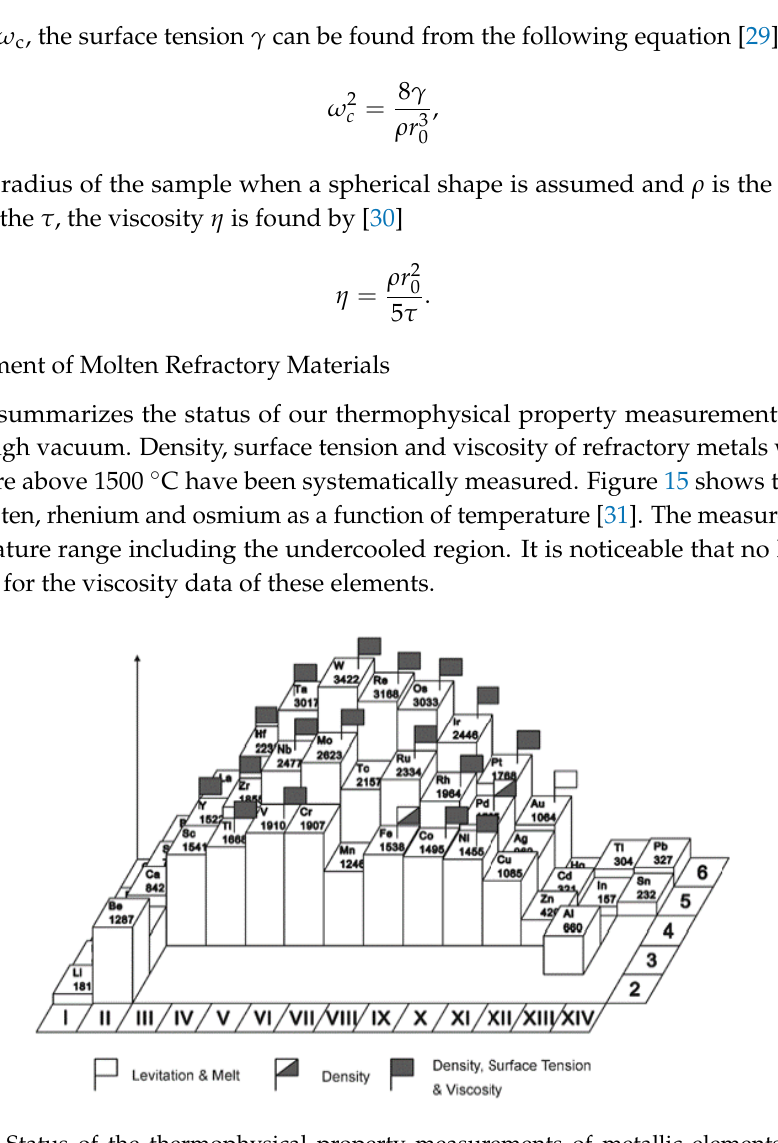
Figure 14. Status of the thermophysical property measurements of metallic elements using an electrostatic levitation furnace in JAXA. In the periodic table, vertical extent of the elements corresponds to their melting temperature. Flags depict the status of measurements for each element.